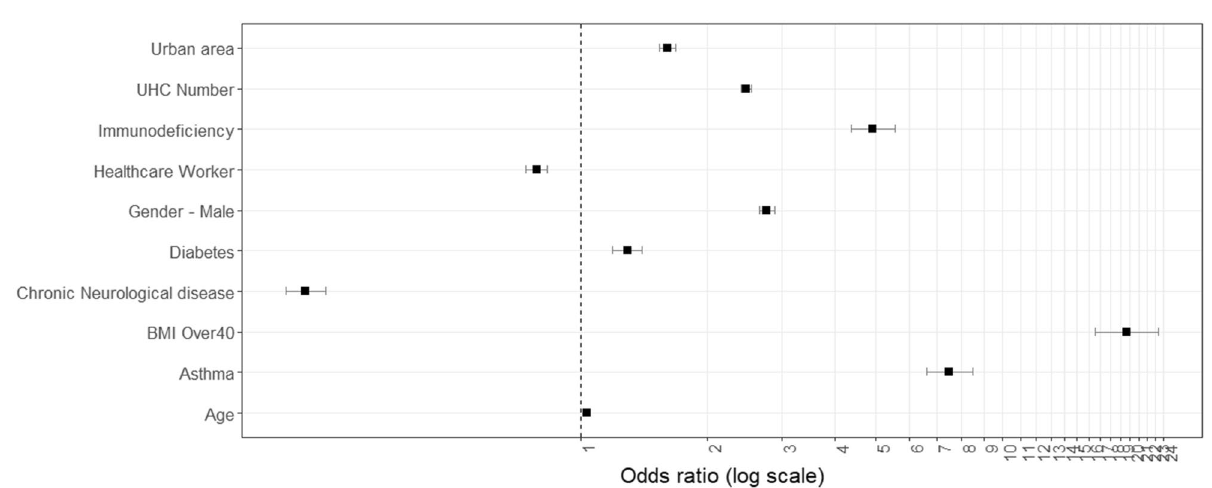
Figure 3. Forest plot of adjusted odds ratios for ICU admission from validated generalised linear